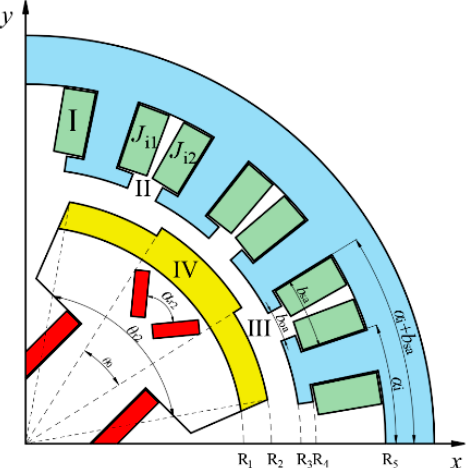
Figure 8. Schematic diagram of the regional division of the salient-pole generator. Where R 1 –R 5 is the radius of the corresponding boundary, b oa is the mechanical angle occupied by the equivalent posterior stator notch, b sa is the equivalent mechanical angle occupied inside the stator slot. Depending on the excitation source, the magnetic field control equations of each subdomain are different, and the vector magnetic quantity of the stator slot (subdomain I) and the PM (subdomain IV) satisfies the Poisson’s equation, and the stator slot notch (subdomain II) and the air gap (subdomain III) satisfy the Laplace’s equation [22].